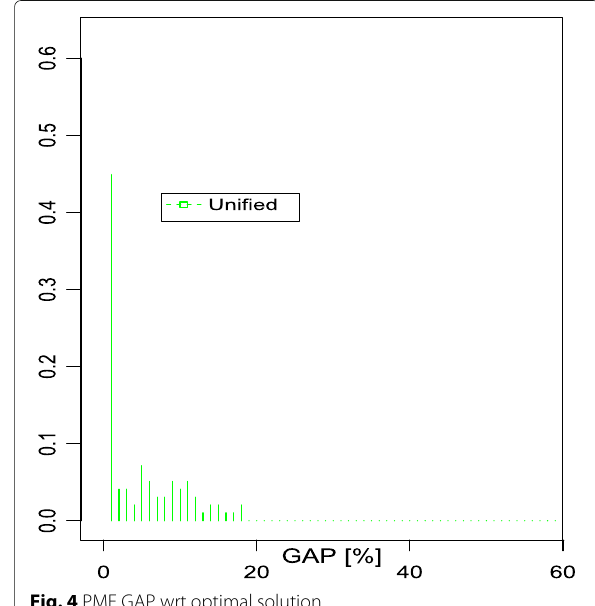
Fig. 4 PMF GAP wrt optimal